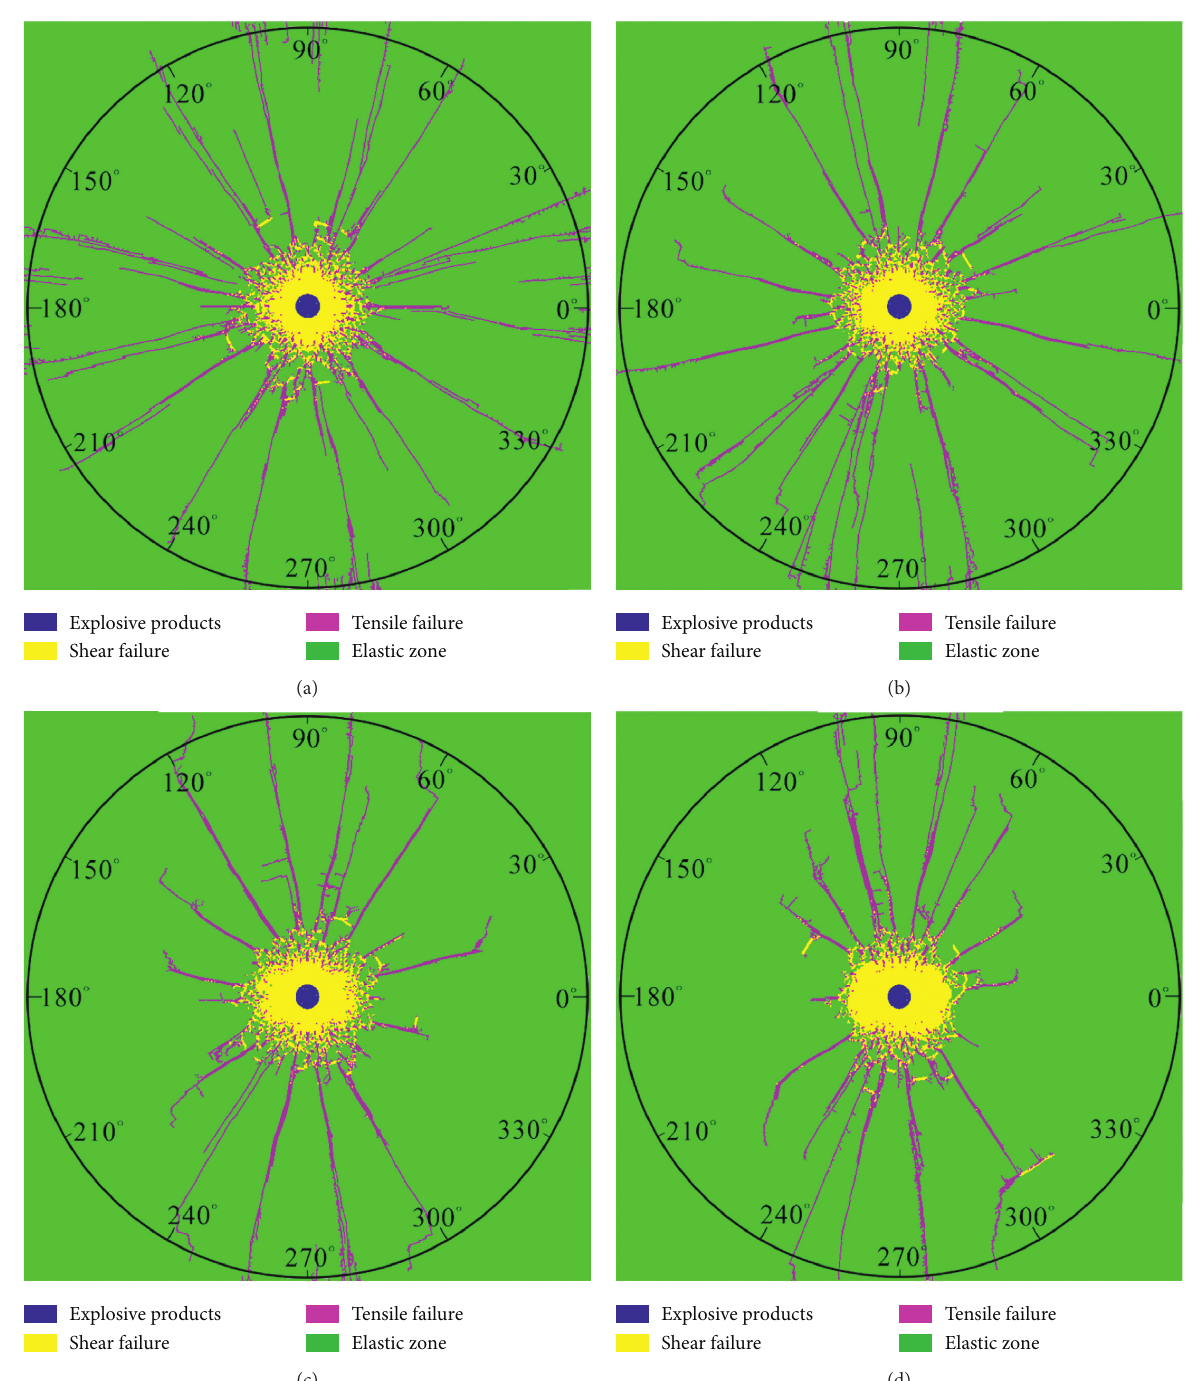
Figure 16: Comparison of blast-induced fractures under different P P y � 15MPa. (c) P x � 5MPa, P y � 25 MPa. (d) P x � 5MPa, P y � 35